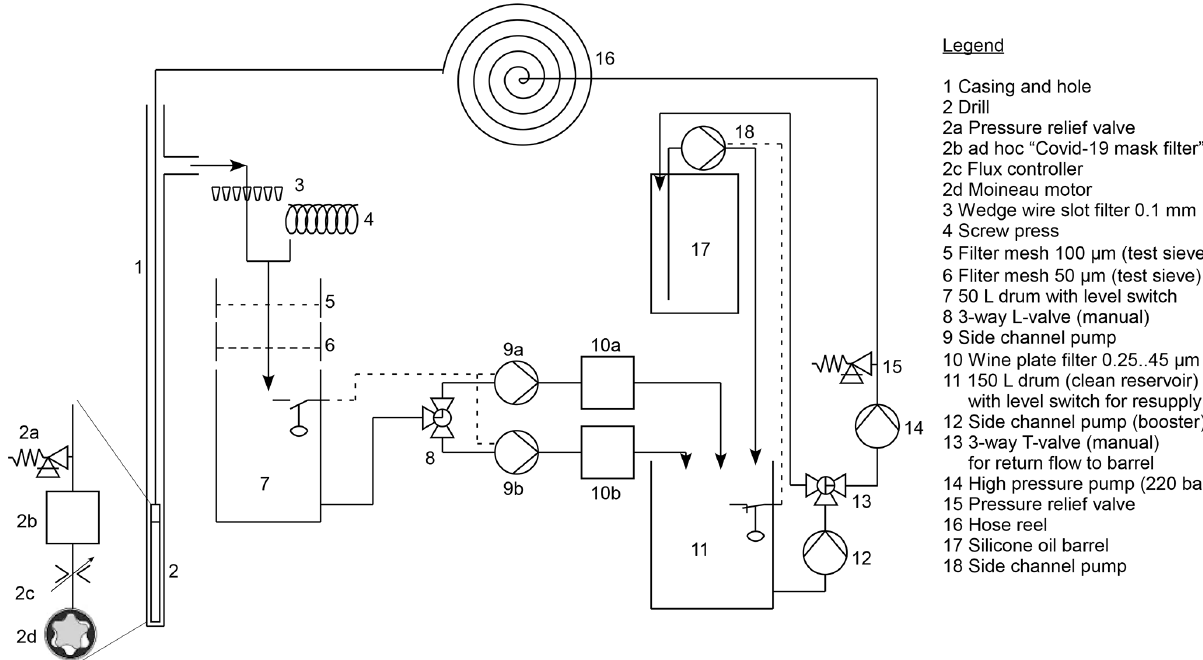
Figure 8. Schematics of RADIX fluid circulation.